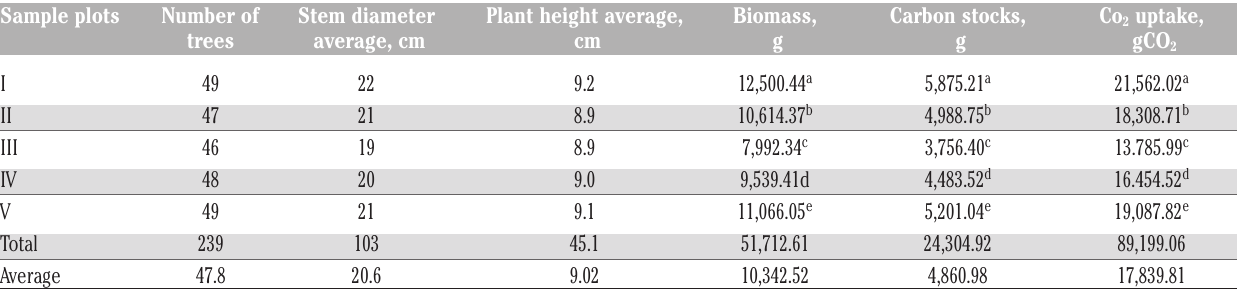
uptake in 5 sample plots per unit area of 0.2 ha. 2